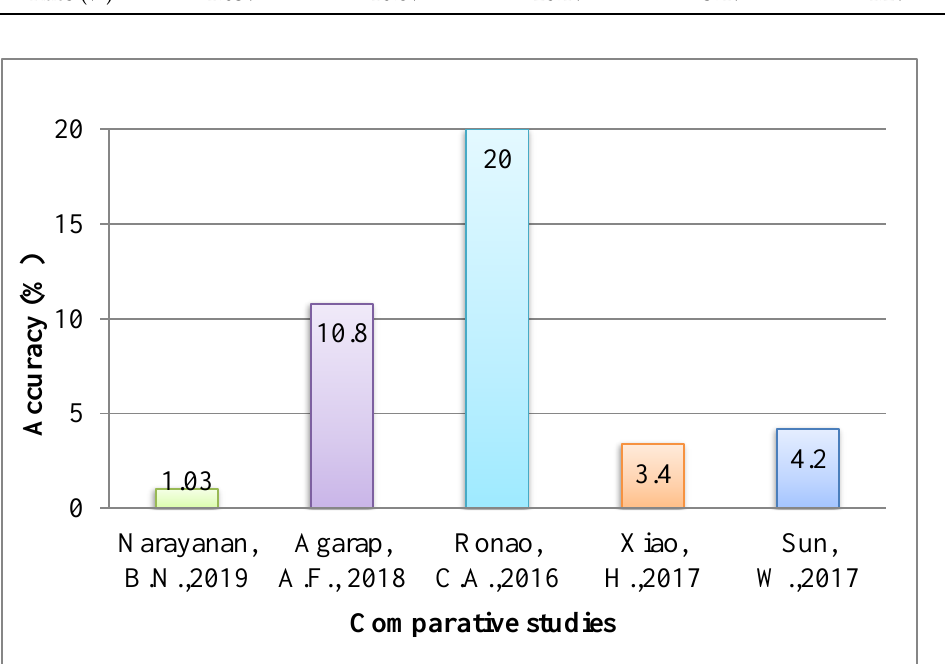
Figure 12. Percentages of improvement in accuracy rates.